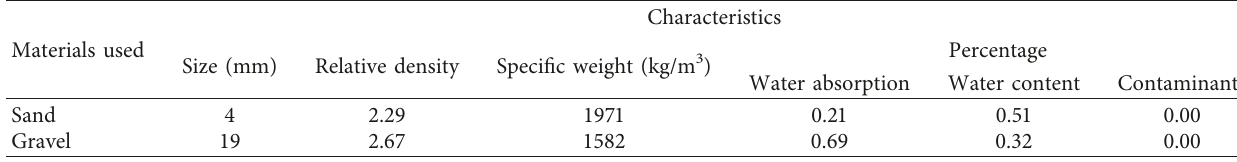
Table 3: Physical characteristics of fine and coarse aggregates.